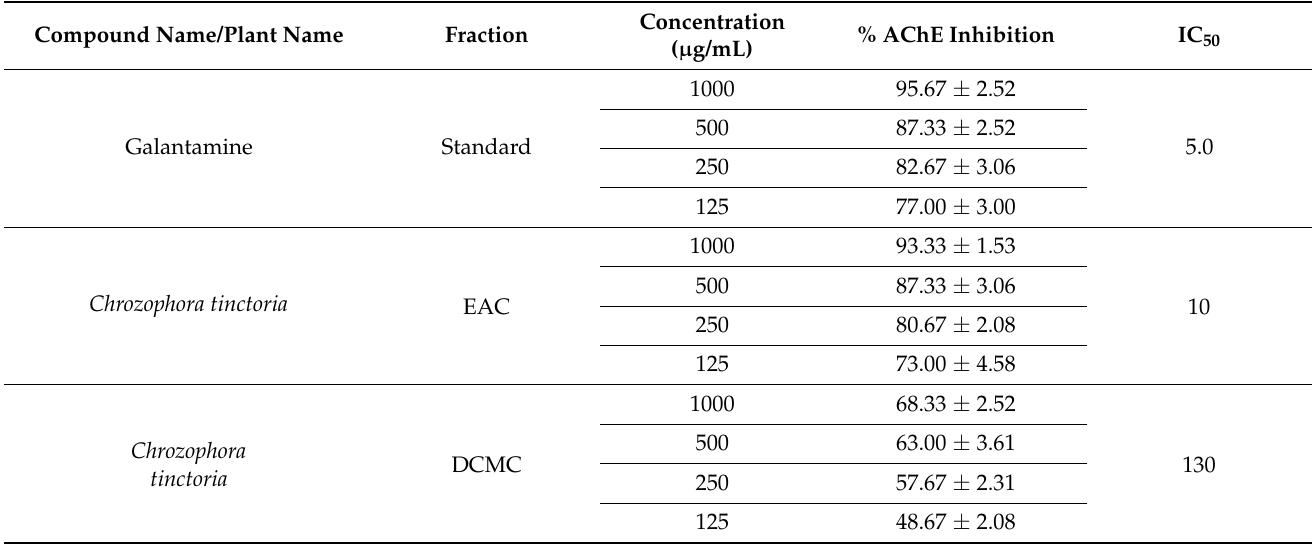
Table 3. Percent inhibition of acetylcholinesterase by EAC.